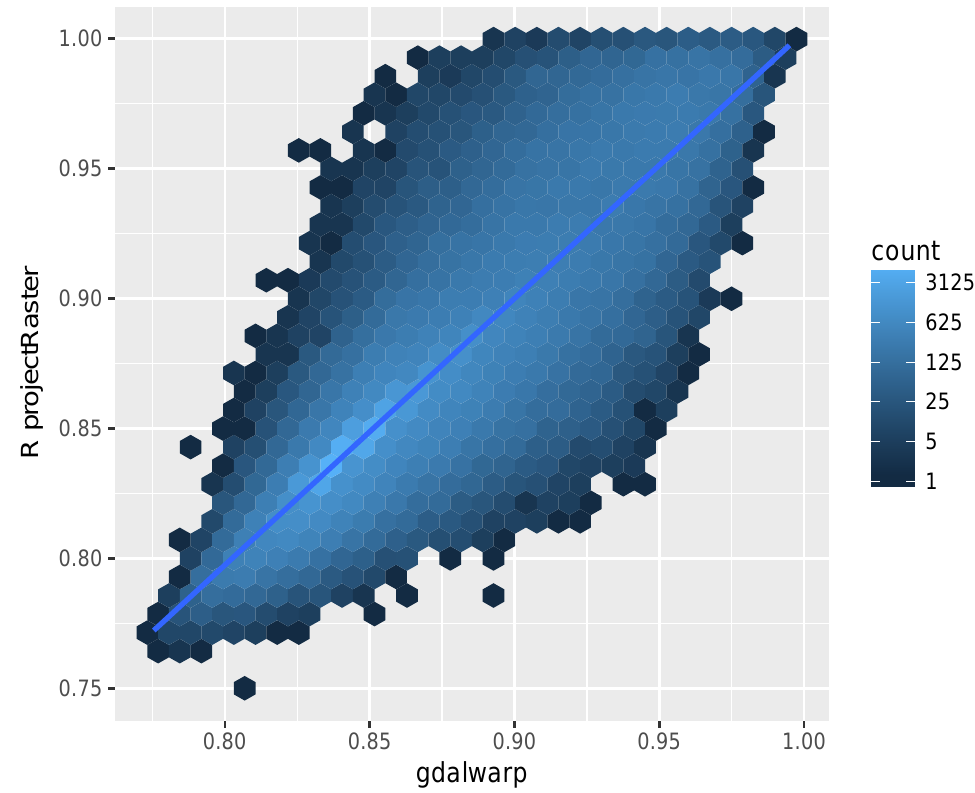
Figure 4. Comparing using the bilinear resampling of projectRaster and gdalwarp to reproject and resample the grid of Landsat 8 image to the grid of the MODIS 09Q1